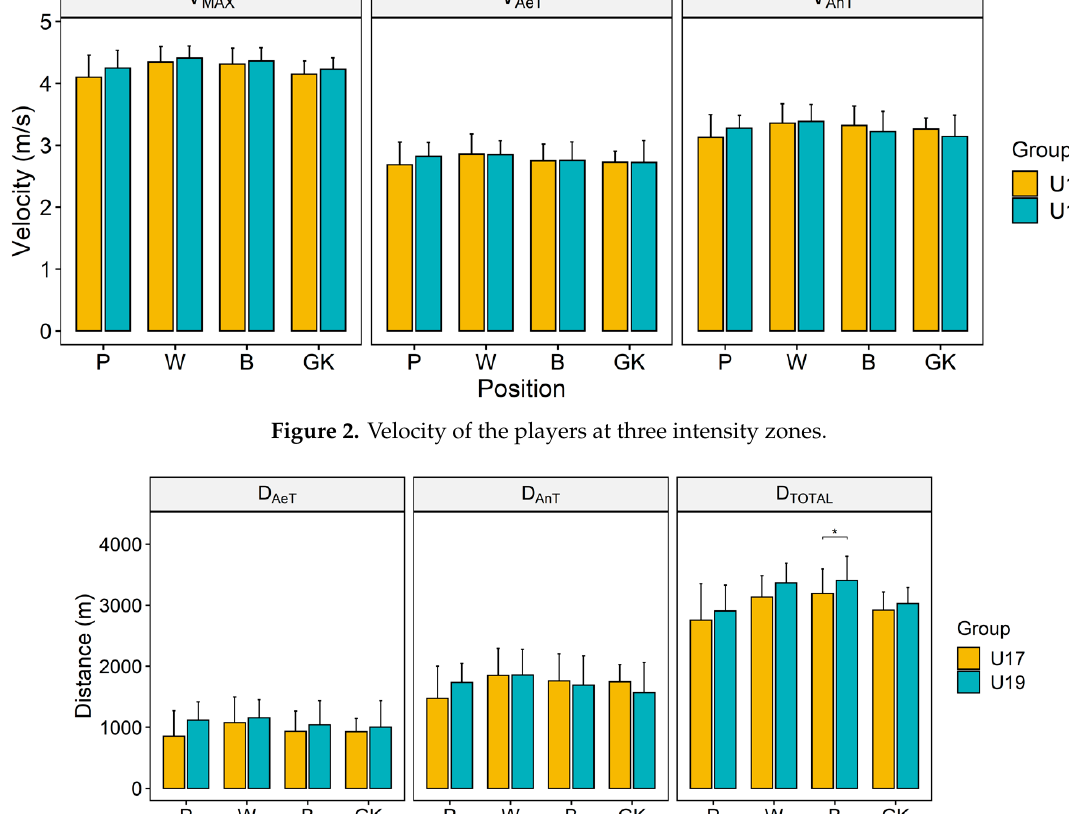
Table 5. Internal load parameters of the